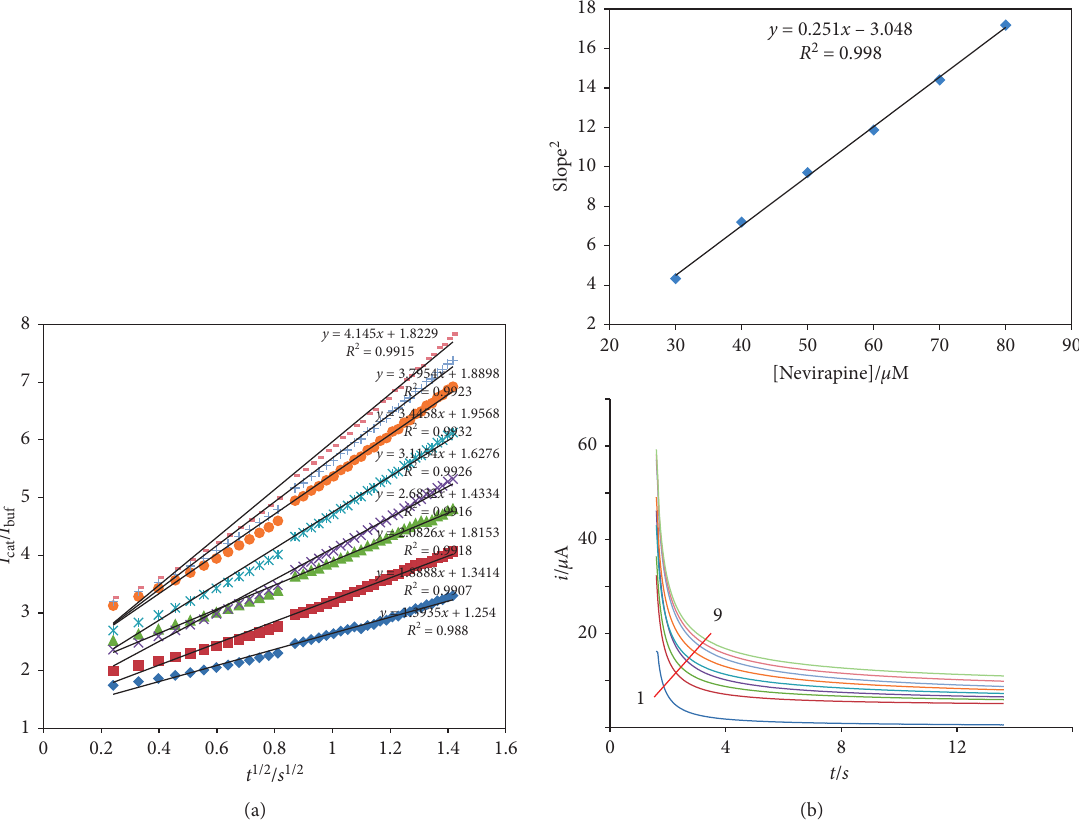
Figure 6: Chronoamperograms for different nevirapine concentrations in 0.1 M PBS (pH 11), curves 2–9: 0.1–0.7 µ M. Insets: (a) plots of i i buffer versus t 1/2 ; (b) Slope 2 versus [nevirapine].